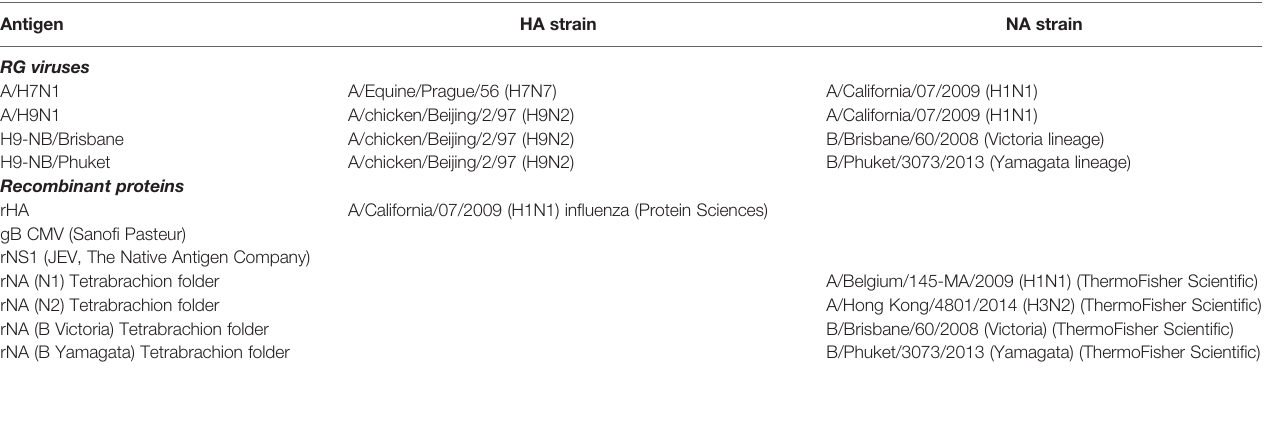
TABLE 1 | Reverse Genetics (RG) viruses and recombinant proteins use in the study. Antigen HA strain NA